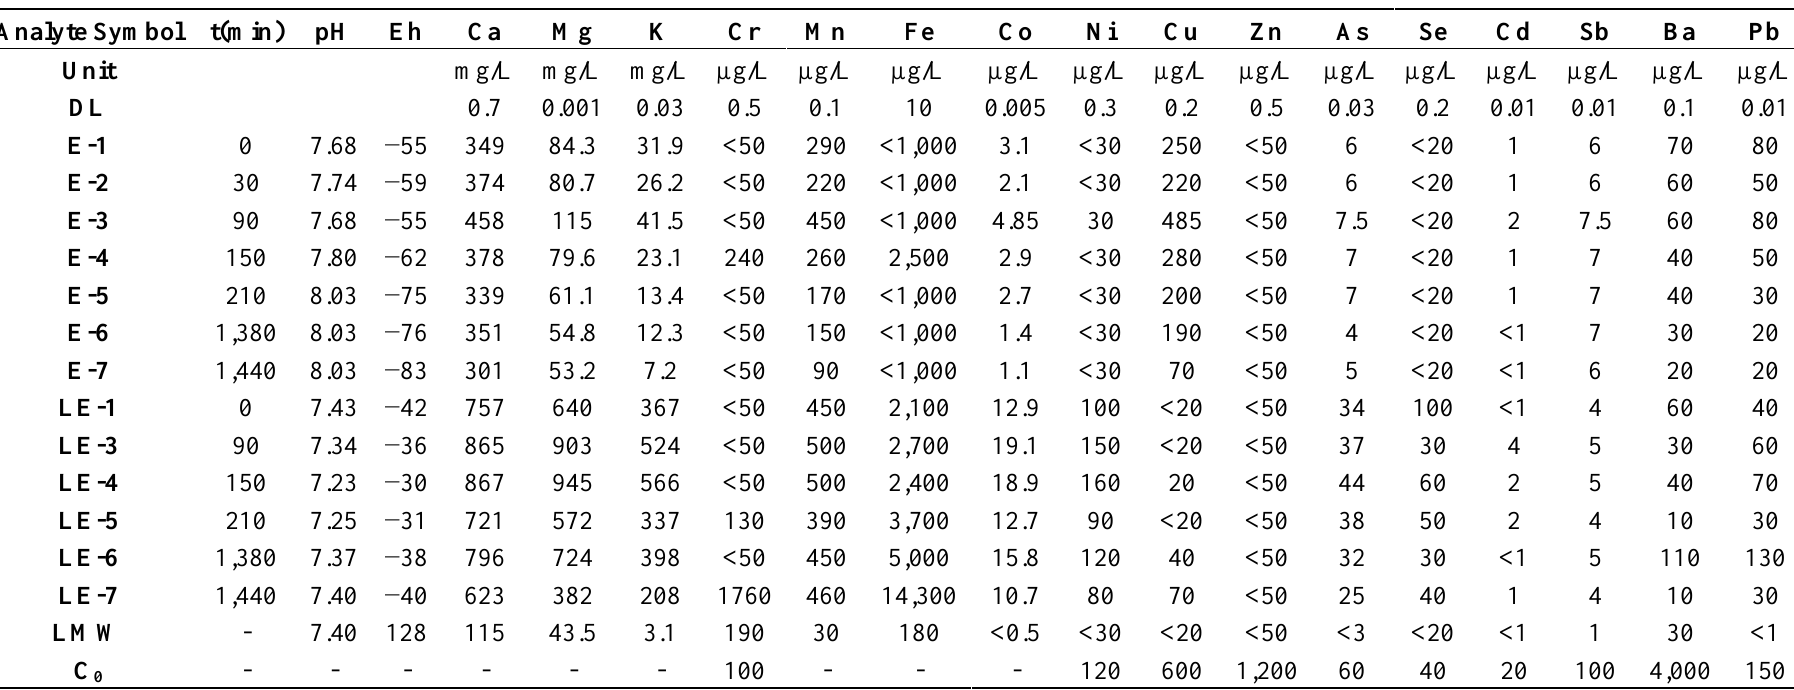
Table 4. In situ determinations and metal concentrations of leachates of pilot-scale experiments. Values in μg/L; Eh: mV. Analyte